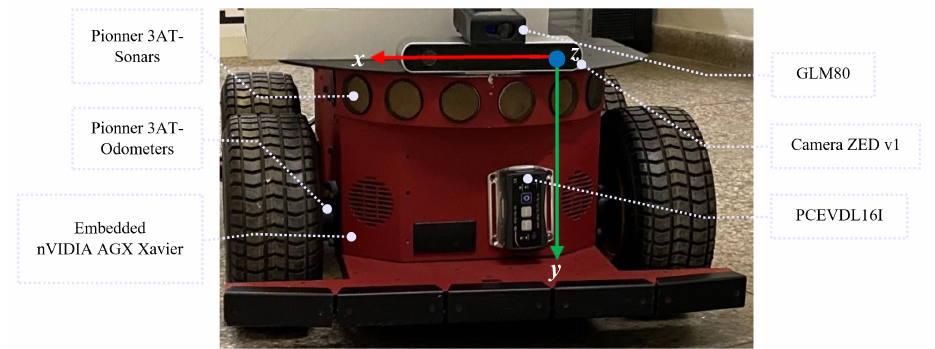
Figure 13. Hardware used for the experiments consisted of a Pioneer AT robot with the ZED stereo camera mounted on its top, and with the coordinate system origin referenced to the left camera center. The x axis is to the right of the robot (red arrow), y is pointing down (green arrow), and z is to the front (forward) of the robot (a right-hand coordinate system is used).